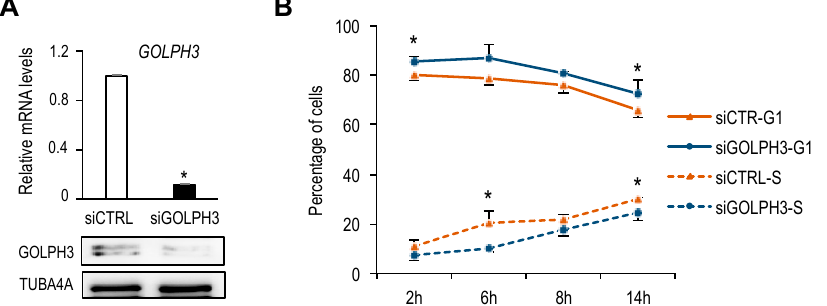
Figure 6. GOLPH3 expression is necessary for timely G1-phase progression. ( A ) RT-qPCR and Western analysis of U2OS cells transfected with non-target control siRNAs (siCTRL) or with siRNAs specific for GOLPH3 (si GOLPH3 ). mRNA expression values were normalized to the expression of EIF2C2 , used as standard control. Data are represented as fold-change (mean + SD) relative to siRNA control. *, p < 0.05. GOLPH3 protein levels were assessed by Western analysis with a specific antibody. ( B ) U2OS cells were transfected with control or GOLPH3 -specific siRNAs and subsequently synchronized in mitosis by Thy-Noc treatment. After release of cells into the cell cycle, samples were collected at several time-points, incubated with PI and cell cycle phases were assessed by FACS analysis. Data represent the mean ± SD of the fraction of siCTRL or si GOLPH3 -transfected cells in G1 or S at each time-point obtained from three independent experiments. *, p < 0.05.